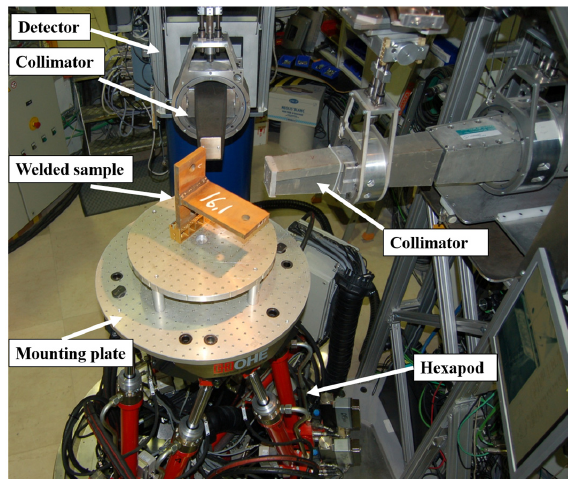
Figure 2. Experimental setup for residual stress measurements in a T-shaped welded sample in the SALSA instrument.